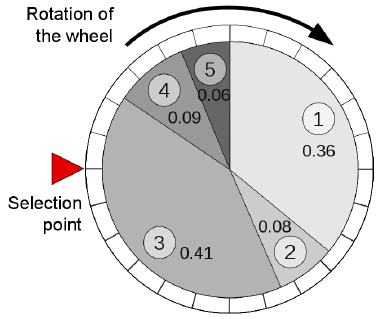
Figure 4. Example of roulette wheel